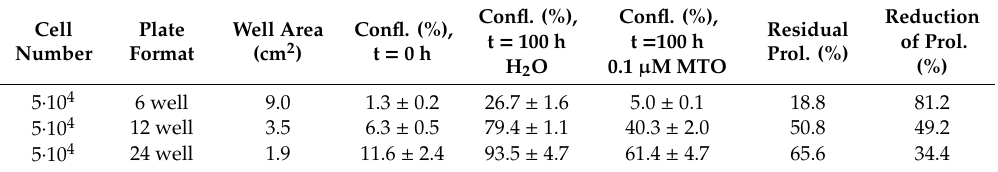
Table 1. Confluence of 5 · 10 4 HT-29 cells seeded in 6-, 12-, 24-well plates as monolayers. Shown are the mean values of 2–4 wells (with 3–4 pictures per well) with standard deviations.